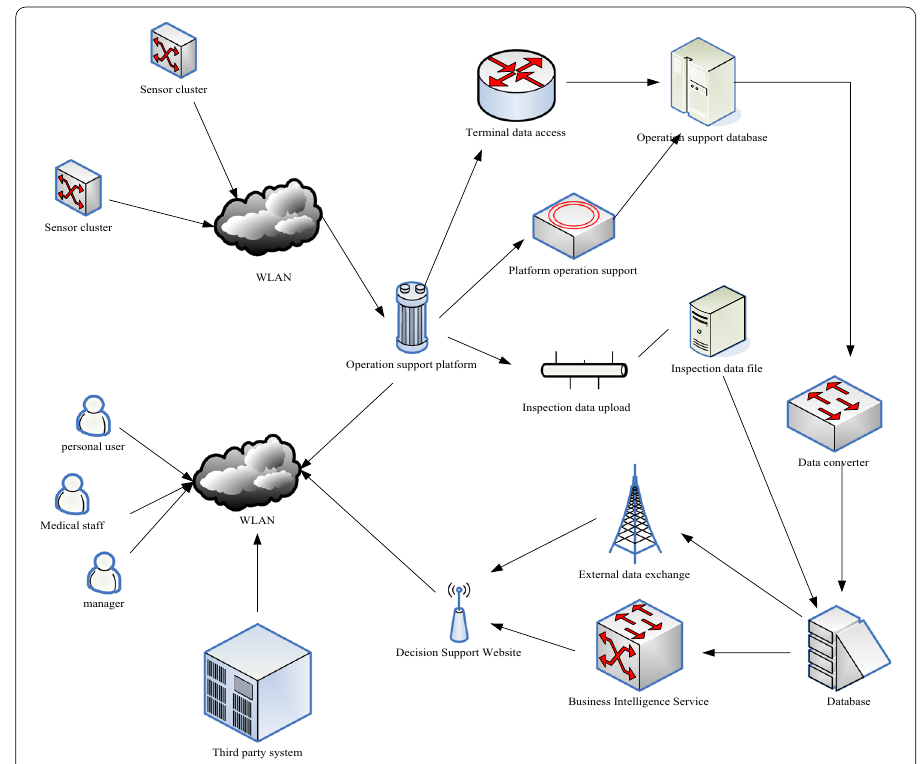
Fig. 1 Data architecture